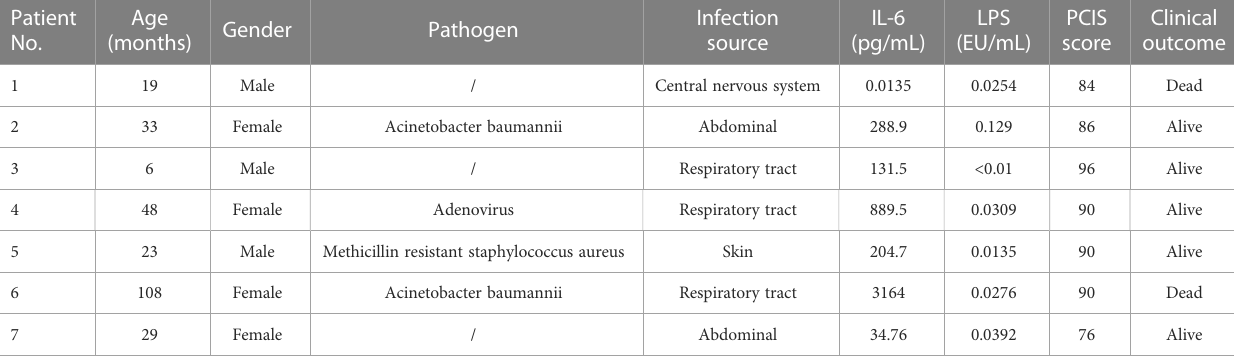
TABLE 1 Characteristics of serum from septic shock children used for cell stimulation. Patient